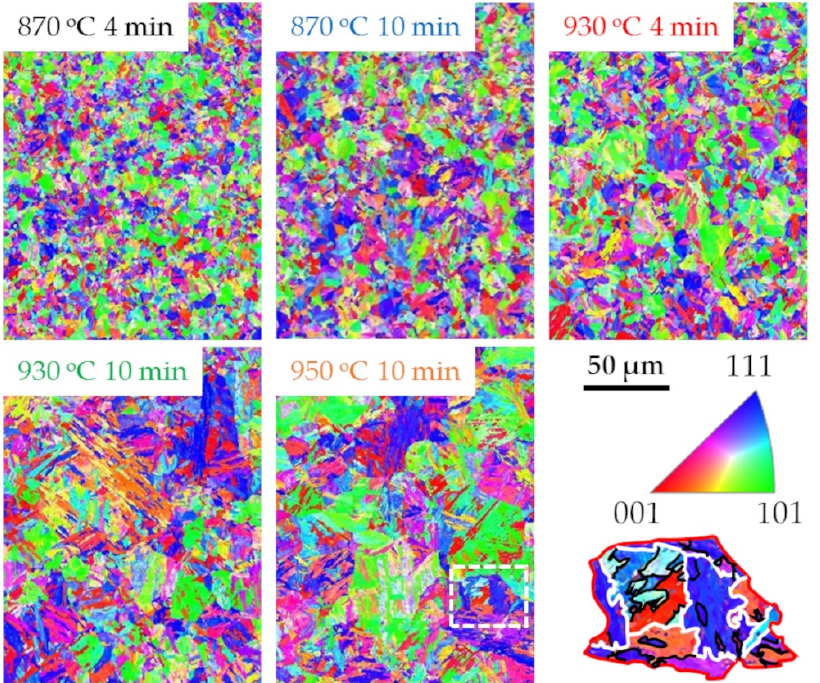
Figure 1. EBSD inverse pole figure maps of the low-carbon fully martensitic steel following five heat-treatments and the associated color-coded stereographic triangle (bottom right). Zoomed view of the region highlighted with a dashed box in the IPF map for 950 °C 10 min heat-treated material showing blocks (identified by solid black lines) and packets (identified by solid white lines) within a prior austenite grain (identified by solid red lines).